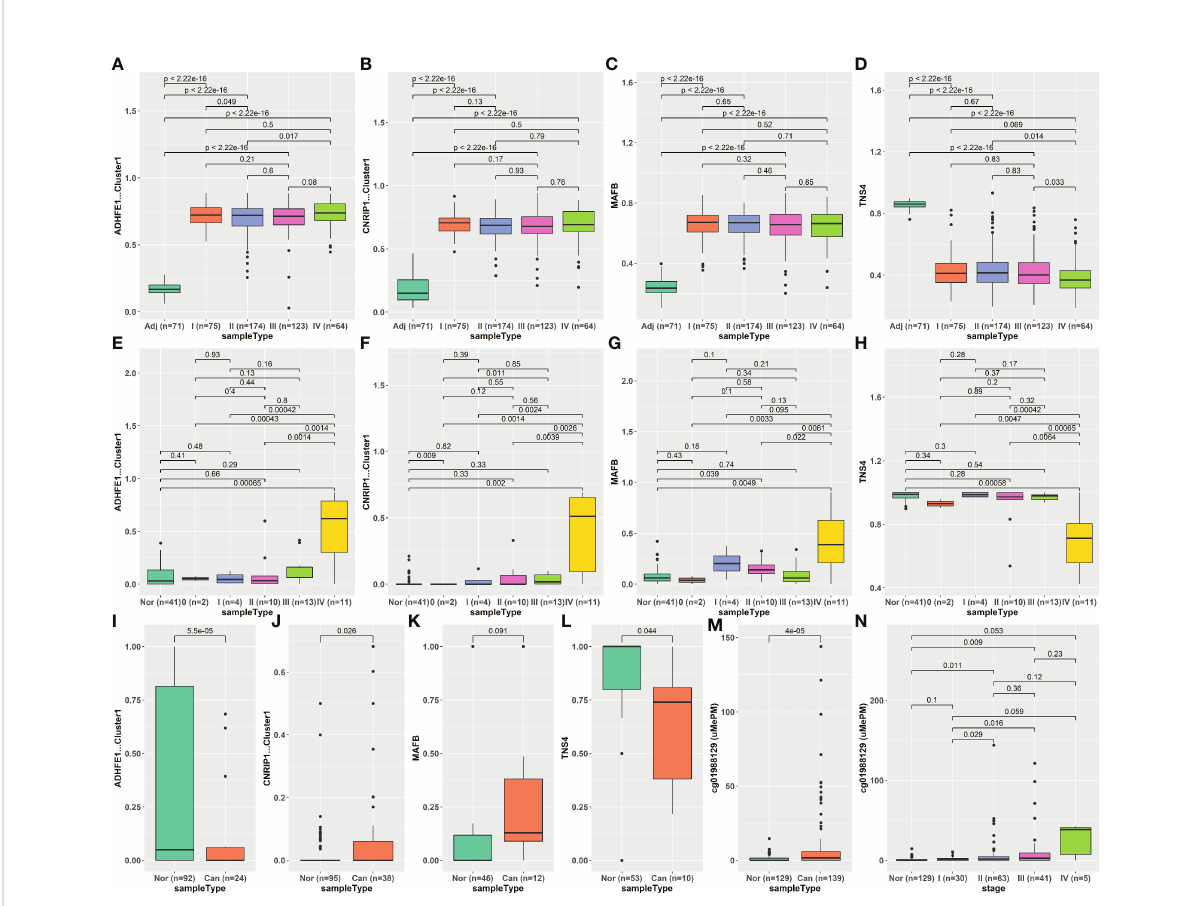
FIGURE 8 Methylation levels of iRFE MDGs of different stages in tissue and cfDNA. (A – D) Tissue DNA from TCGA-COAD dataset. (E – H) CfDNA from GSE149438 dataset. (I – L) CfDNA from CFEA dataset. (M, N) cfDNA from GSE124000 dataset. iRFE, iterative recursive feature elimination; MDGs, methylation-driven genes; cfDNA, cell-free DNA; CFEA, Cell-Free Epigenome